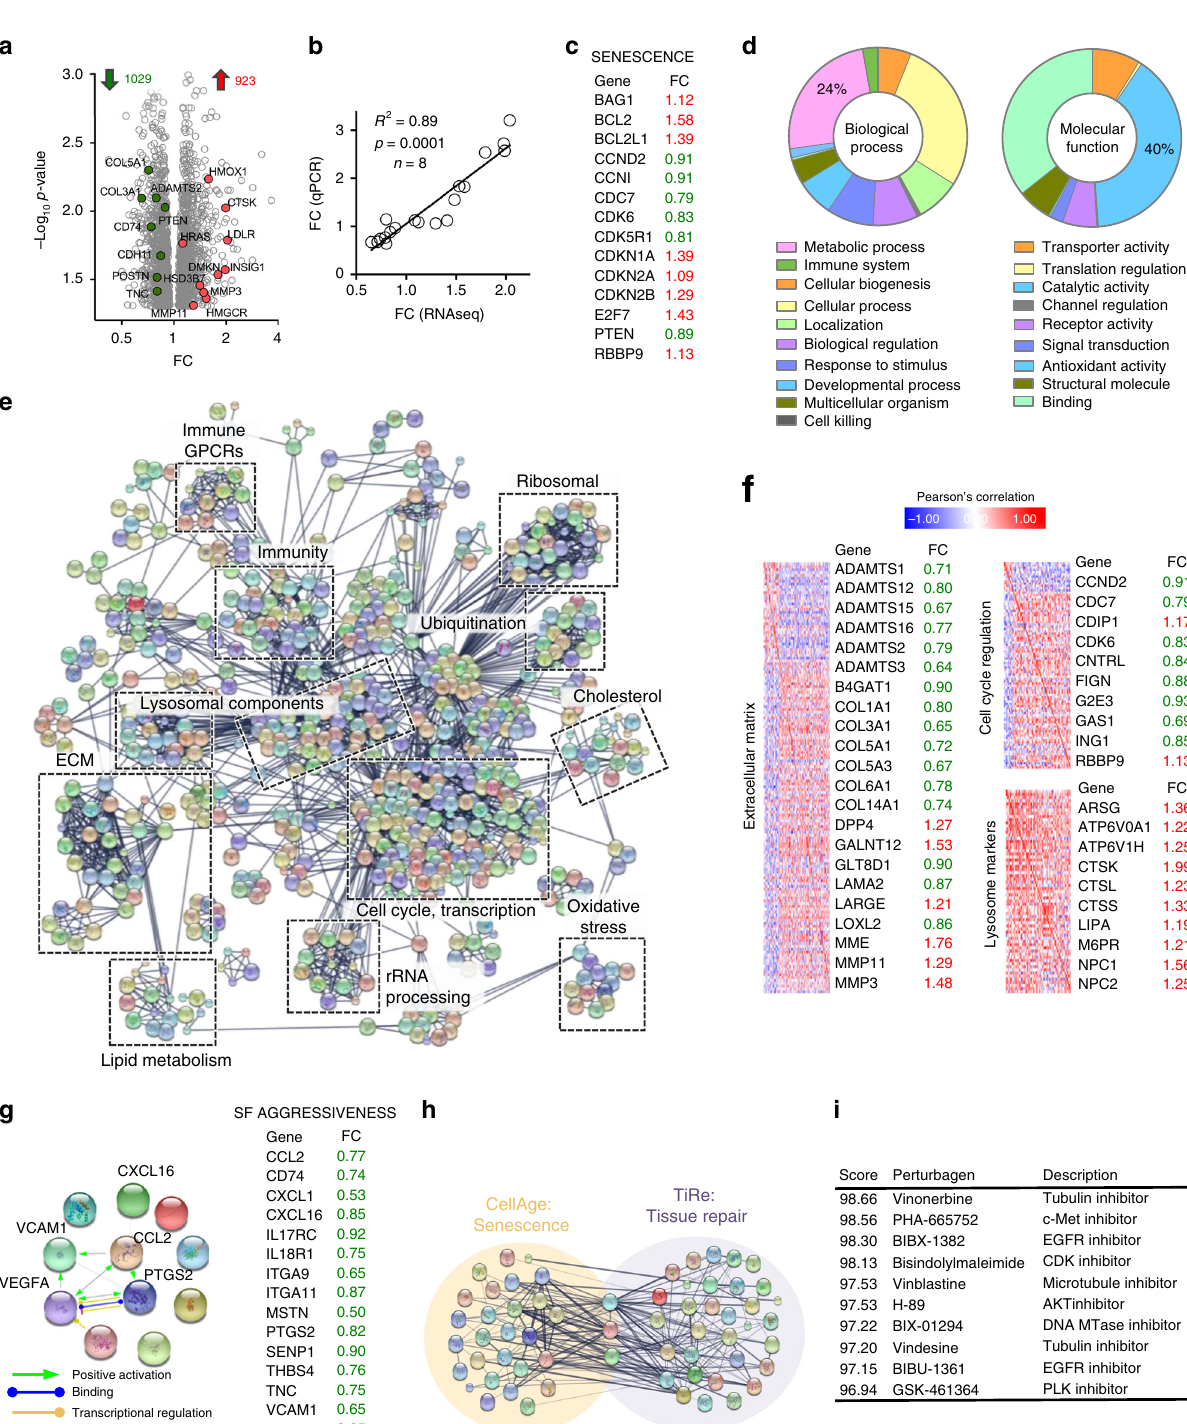
genes, of which 19 were selected for validation by qPCR (Fig. 3a, b, Supplementary Tables 2 and 3), indicating a robust correlation between RNAseq and qPCR data. Modulation of several genes related to senescence and cell cycle regulation was identi fi ed (Fig. 3c, Supplementary Fig. 2A), including down-regulation of cyclins ( CCND2 , CCNI ), up-regulation of the CDK inhibitors p16 INK4 , p21, and p15 ( CDKN2A , CDKN1A , CDKN2B ), and increase of pro-survival signals typical of senescent cells ( BAG1